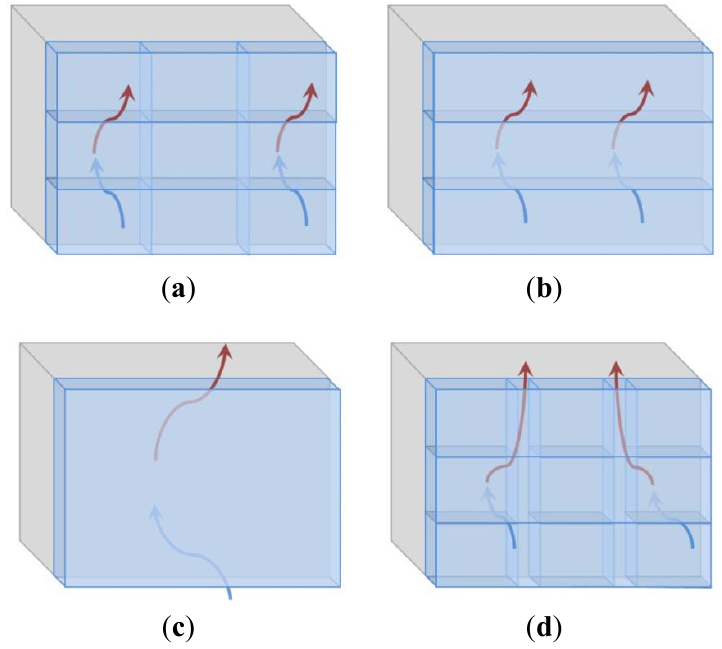
Figure 4. The shape and airflow of DSF: ( a ) Box type; ( b ) Corridor type; ( c ) Multistory type; ( d ) Shaft box